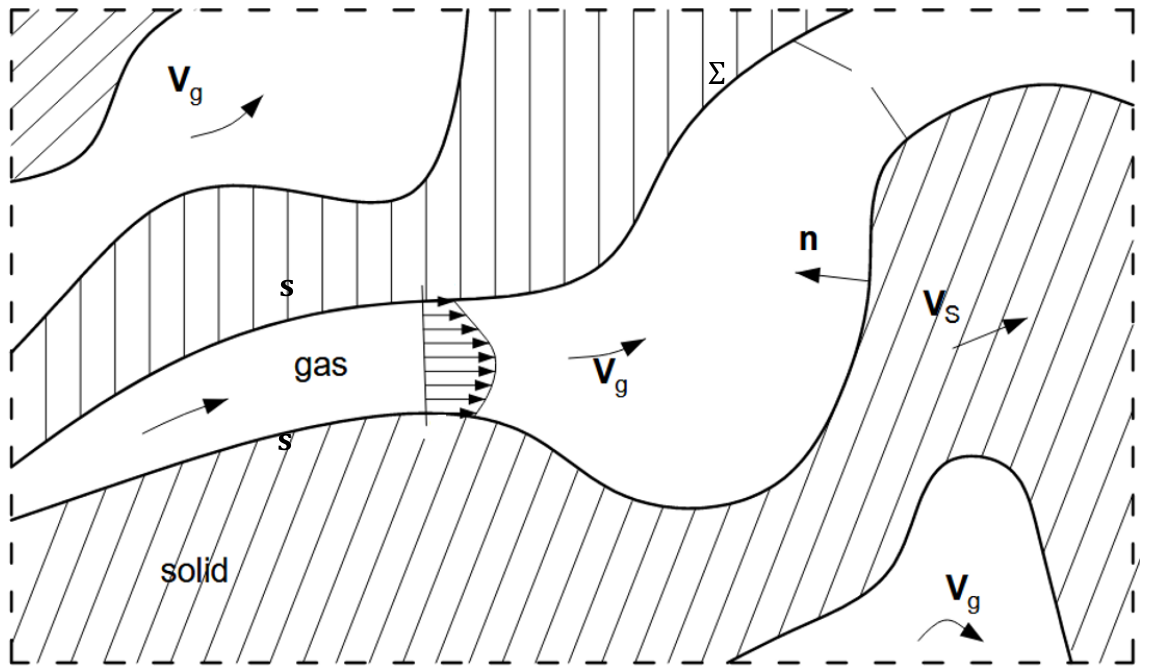
Figure 4. Scheme of porous continua filled with gas catalytic combustion.